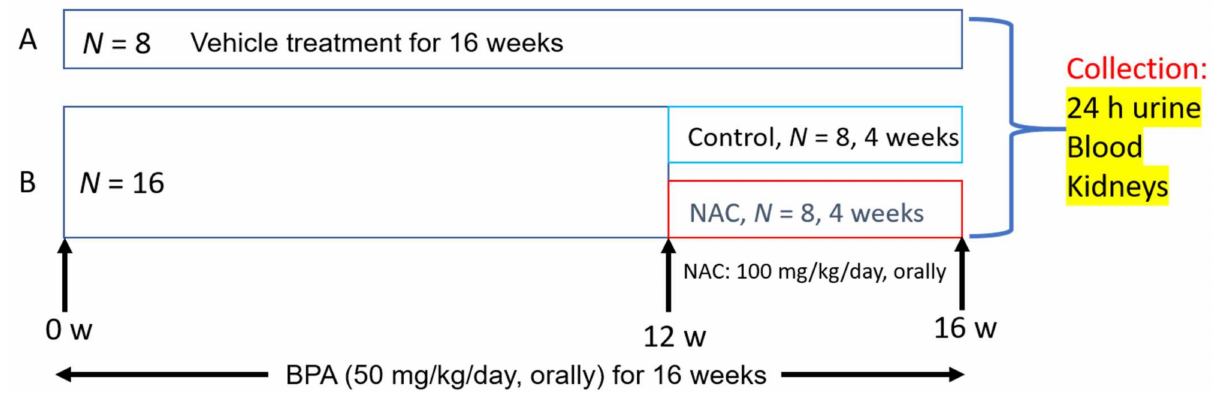
Figure 1. Experimental scheme and design of bisphenol A (BPA: 2,2-bis-(4-hydroxyphenyl)-propane) administration and N-acetylcysteine (NAC) treatment. Both BPA and NAC were administered orally.